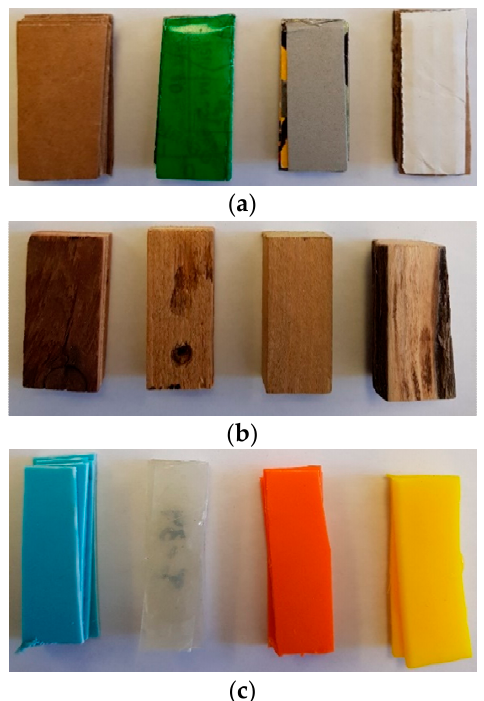
Figure 5. Pictures of a few samples measured for each category: ( a ) cardboard samples, ( b ) wood samples, and ( c ) plastic samples.